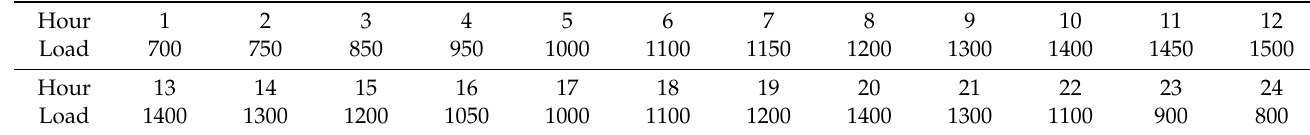
Table 5. Load Data.